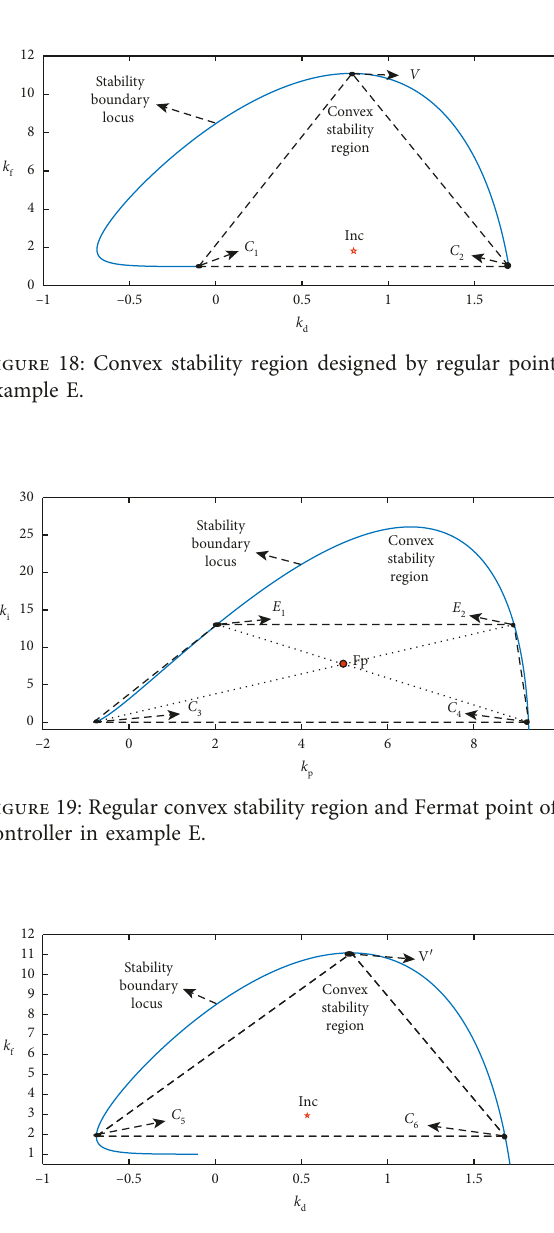
Figure 20: Changed convex stability region and incenter of PD controller in example E.